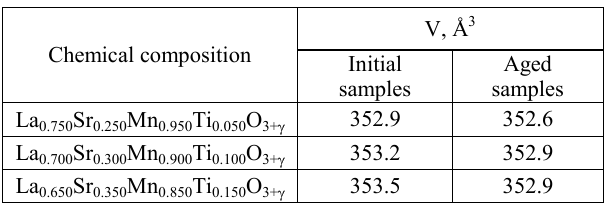
Table 2 . Full width (W) at half maximum of diffraction